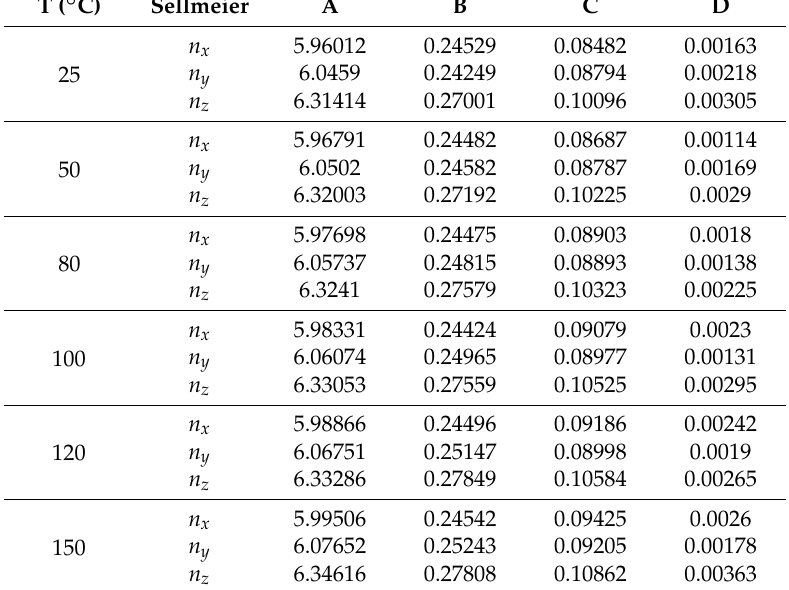
Table 3. The Sellmeier coefficients ( × 10 − 5 ) of BaGa 4 Se 7 crystal at different temperatures.